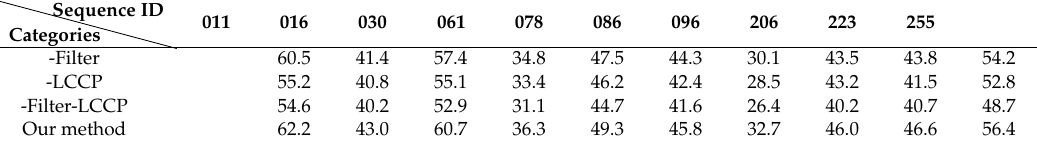
Table 3. Ablation experiments on 10 sequences of SceneNN dataset (units: %).